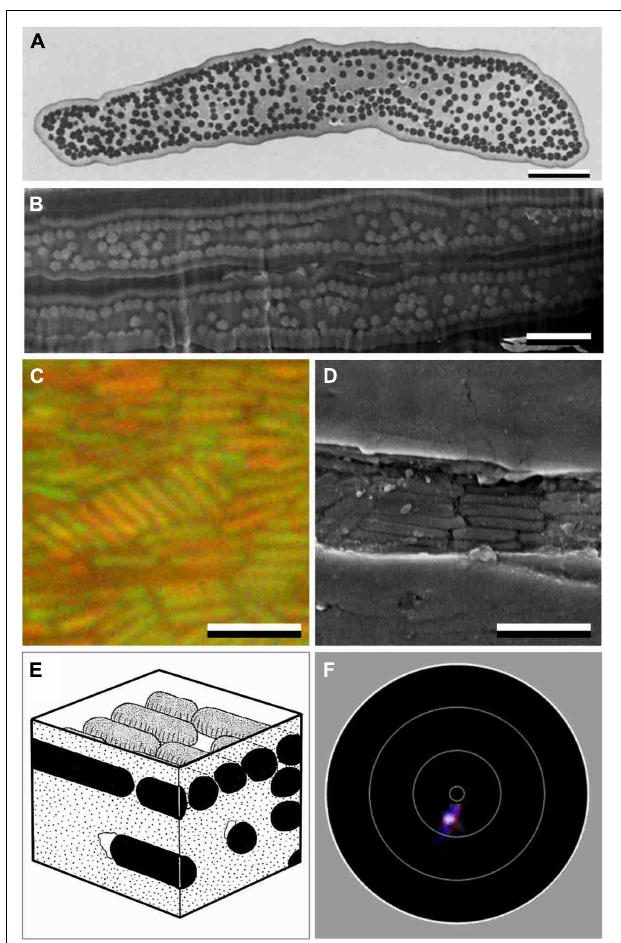
FIGURE 2 | Anatomy and scatterometry of starling barbules with solid melanosomes. (A) Transmission electron micrograph of a barbule cross section of the Sulawesi myna starling, Basilornis celebensis [modified after Durrer (1977)]. (B) FIB-SEM of a cross-section of two adjacent barbules of a S. vulgaris feather. (C) Epi-illumination micrographs of a green barbule of S. vulgaris in oil immersion. (D) FIB-SEM on-view of a S. vulgaris barbule where the cortex was accidently absent. (E) Diagram of a S. vulgaris barbule with melanosome rodlets in a keratin matrix [from Durrer (1977)]. (F) Imaging scatterogram of a purple barbule of S. vulgaris . The white circles in the diagrams indicate polar angles of 5 ◦ , 30 ◦ , 60 ◦ and 90 ◦ . Scale bars: (A–D) 2 µ